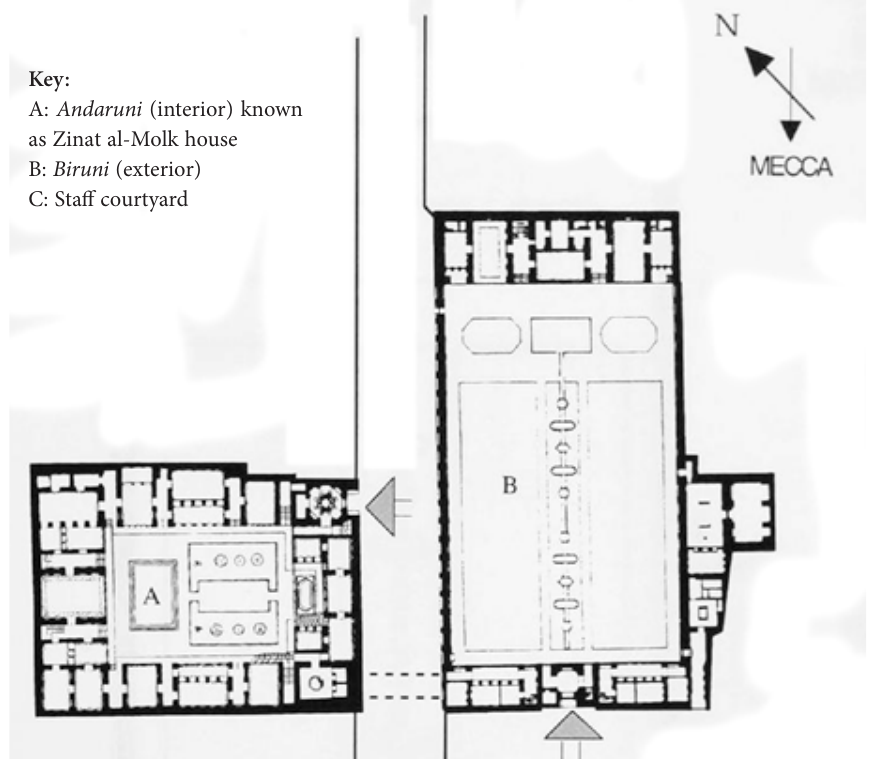
Figure 1. Private and public − plan of Qavam house in Shiraz (source: adopted from Memarian,